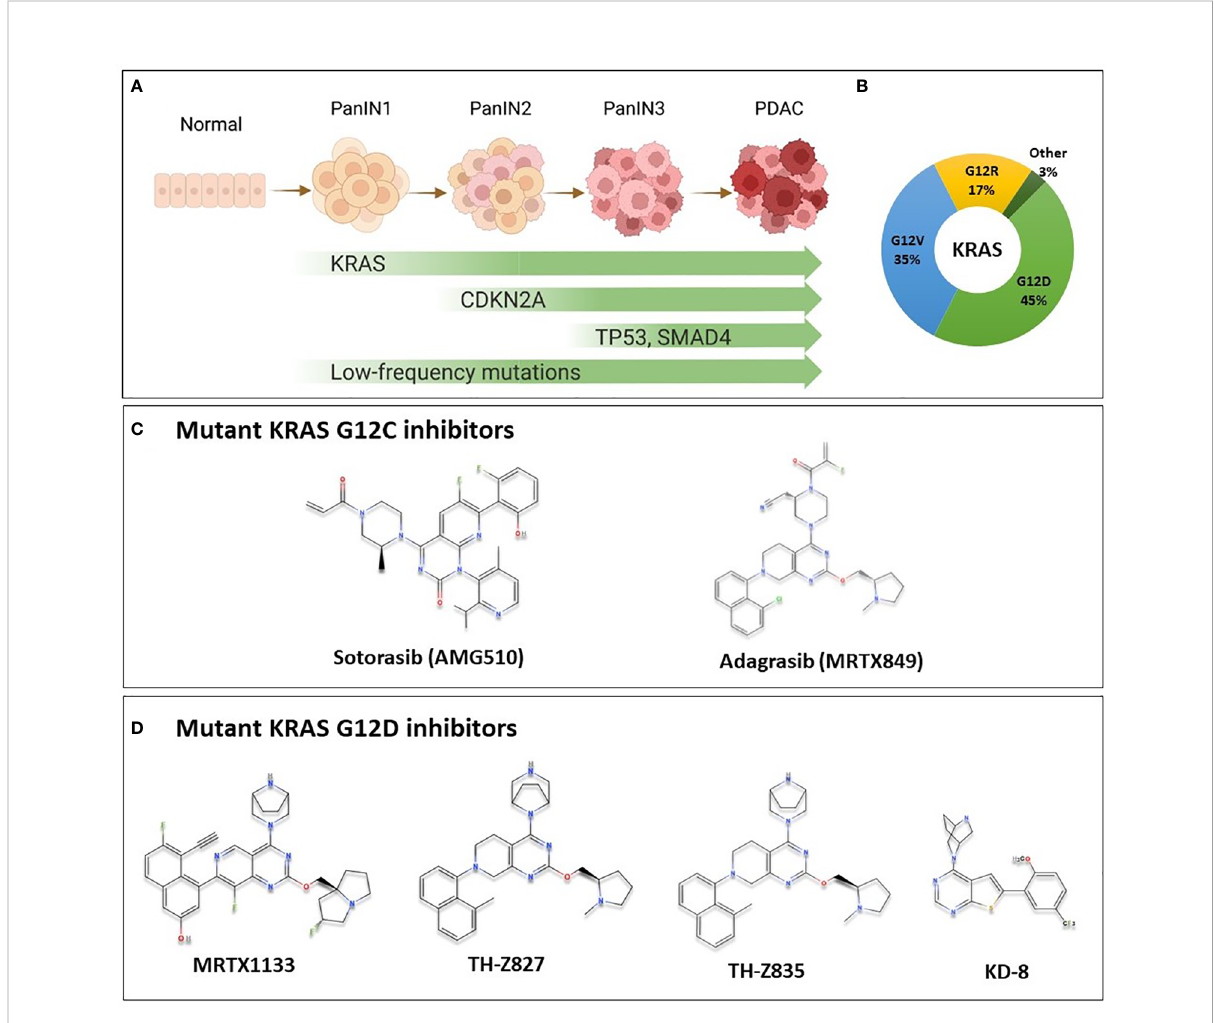
FIGURE 1 KRAS Oncogene in PDAC and the chemical structure of some of mutant KRAS small molecule inhibitors. (A) Multi-stage development model of KRAS-mutated PDAC. As cells acquire mutations in KRAS, CDKN2A, SMAD4 and TP53 in addition to less commonly mutated genes, the lesion progresses from low grade pancreatic intraepithelial neoplasia (PanIN1), through PanIN2, and high grade PanIN3 to become invasive carcinoma. (B) Most common KRAS mutations in PDAC are G12D (45%), G12V (35%), G12R (17%) representing important targets for PDAC patients. Other mutations such as G12C, G12A and others are less common (3%). (C) Sotorasib and adagrasib are mutant KRAS G12C inhibitors. They bind speci fi cally to the mutant form by making covalent interactions with Cys12 in the switch-II pocket of mutant KRAS, locking it in the inactive state, and preventing downstream signaling. These agents have been investigated in clinical trials, and sotorasib is currently FDA approved for the treatment of KRAS G12C-mutated NSCLC. (D) Novel KRAS G12D inhibitors with available chemical structures, MRTX1133, TH-Z827, TH- Z835, and KD-8. These agents bind speci fi cally and non-covalently to mutant KRAS G12D, thereby inhibiting proliferation in mutated cells. These agents are currently in preclinical development, and details on further clinical development are not currently